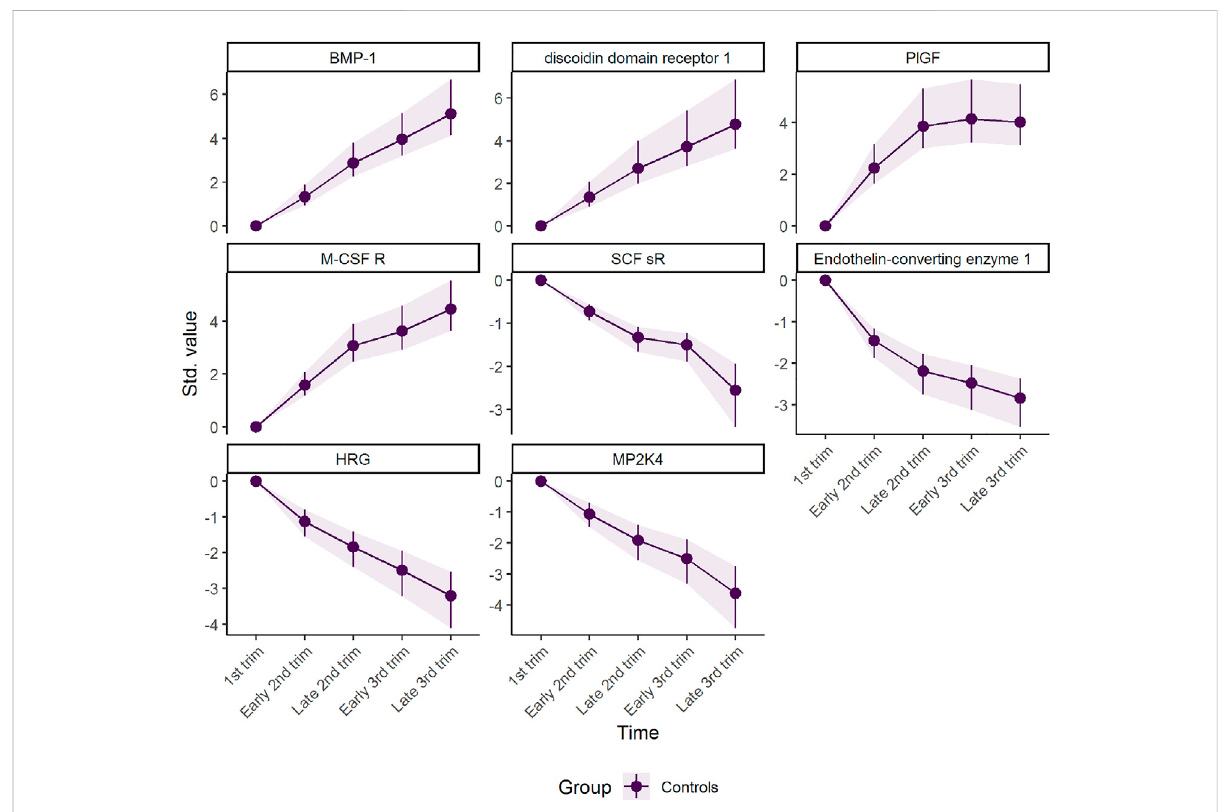
FIGURE 3 Marginal means for scaled protein concentration from linear mixed models. The intercept has been removed to highlight the robustness of development over time. The plot was made with the plot( ... , type = “ prediction ” )